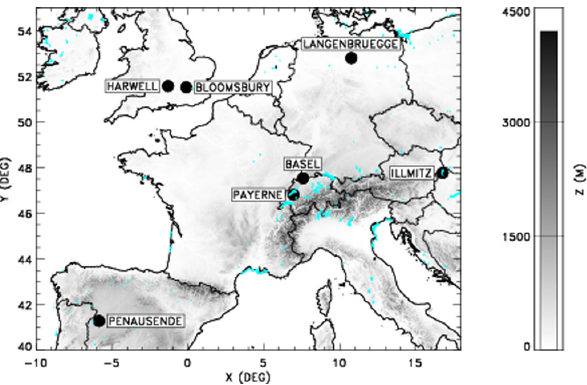
Fig. 1. Locations of the sites used in this